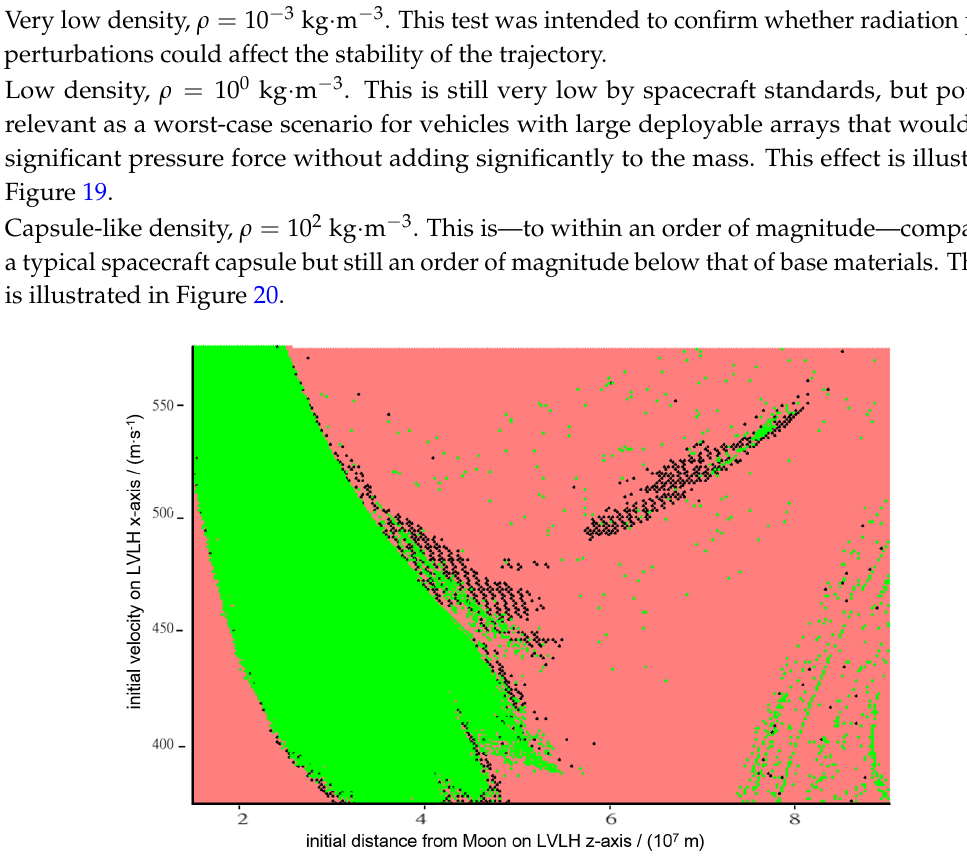
Figure 19. Superposition of the stable (green/light shading) and unstable (red/darker shading) states for the case with radiation pressure. States that were stable without radiation pressure and unstable with radiation pressure are identified with black dots. Most of the minor zones of stability have been destabilized by the effect of radiation pressure. Note—the black dots are taken from the limited data set used to generate Figures 10 and 11 and are set against a higher resolution data set. Consider the black dots as representative of area-shading rather than specific